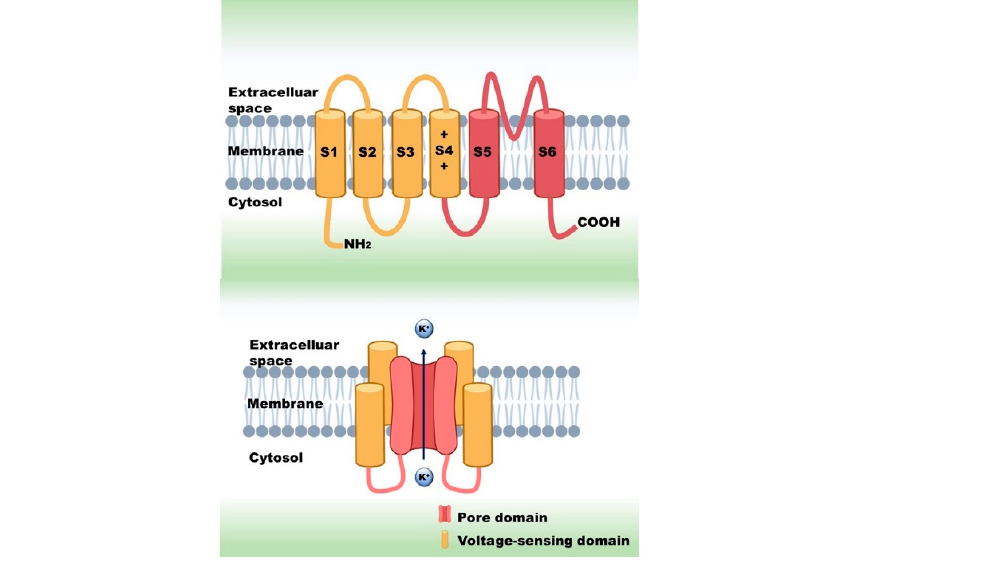
Figure 1. Stucture of voltage-gated potassium channels.